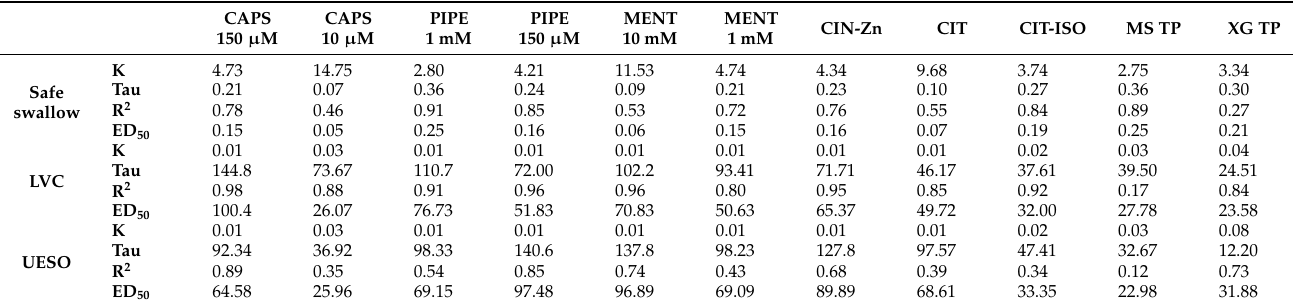
Table 2. Parameters of the one-phase decay curves for the proportion of patients with improved prevalence of safe swallow, time to laryngeal vestibule closure and time to upper esophageal sphinc- ter opening.